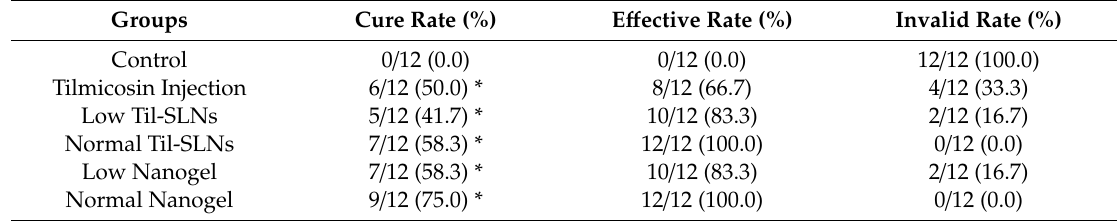
Table 4. The cure rate of S. aureus mastitis treatment experiment ( n =